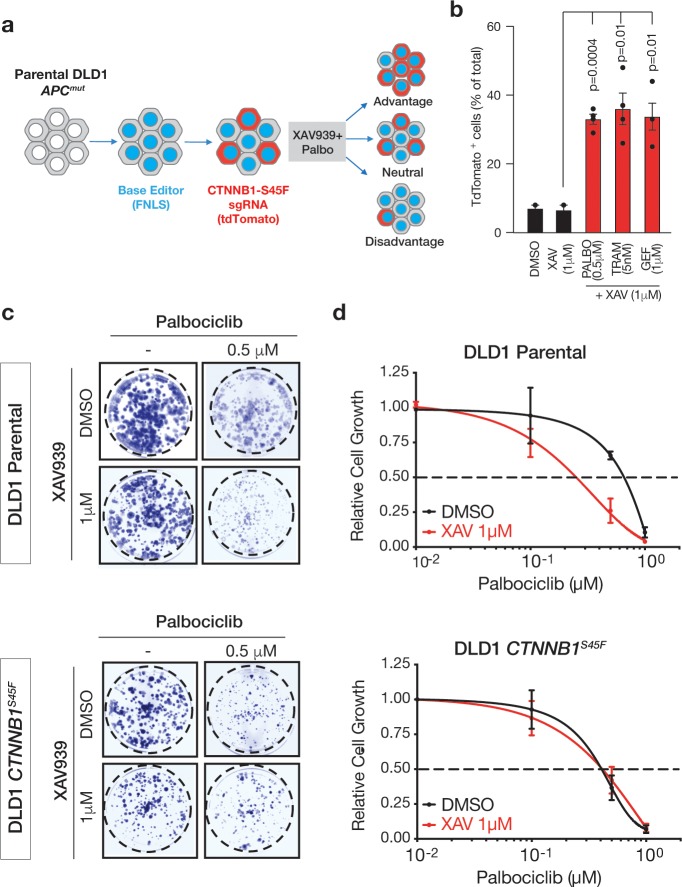
CDK4 and TNKS synergy is dependent on canonical WNT signaling.a. Schematic representation of competition assays, using a LRT2B backbone to track CTNNB1-S45F modified cells. b. Fluorescent competition assay showing the percentage of TdTomato-positive cells after 14 PDLs in the indicated drug concentrations. N = 4 independent experiments, p values were calculated using Student’s t test. c. Colony-forming assays of parental (top panels) or S45F-edited (bottom panels) DLD1 cells, treated with the indicated drug concentrations. d. Relative cell growth, represented as % of DMSO-treated DLD1 cells, calculated from colony-forming assays cells of parental (top) or CTNNB1-S45F (bottom) backgrounds. Cells were treated with increasing Palbociclib concentrations in the absence (black lines) or presence of XAV. N = 3 independent assays, represented is mean and SD.